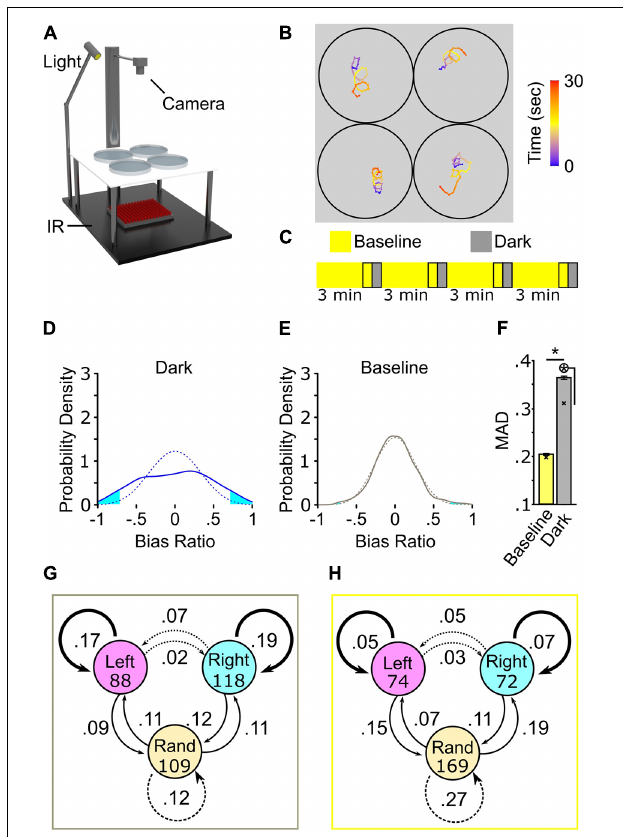
FIGURE 1 | Turning behavior following the loss of light exhibits high inter-individual variation. (A) Schematic of multiplex recording rig. (B) Illustrative path trajectories following loss of light from multiplex recording. Color scale is time (seconds). (C) Diagram of 4 × recording. Outlined regions denote recording intervals. (D–F) 4 × recordings strategy to show high inter-individual variation in turn bias. (D) Average bias ratio probability density curve for dark responses (solid blue line, N = 374) and paired curve following reshuffling (dotted blue line, average of 1,000 resampled datasets). (E) Same as (D) except the paired baseline responses (solid gray line, N = 374) and random permutation density curve (dotted gray line). Cyan fill shows the area in each tail corresponding to the probability of observing a result more extreme or equal to ± 0.3 average bias ratio. (F) MAD for baseline (yellow), and dark (gray) responses. N = 374. Error bars are 95% confidence intervals generated by bootstrap resampling. Asterisk in circle, p < 0.05 to MAD permutation value shown with an X. (G) Dark responses (gray outline) and baseline (H) (yellow outline) from 4 × recording showing frequency of direction change between first (circles) and second (arrows) pairs of responses. Initial N shown in circles. Bold, solid, and dotted arrows delineate responses that produce perfectly matched bias, partial bias, and unbiased responses,